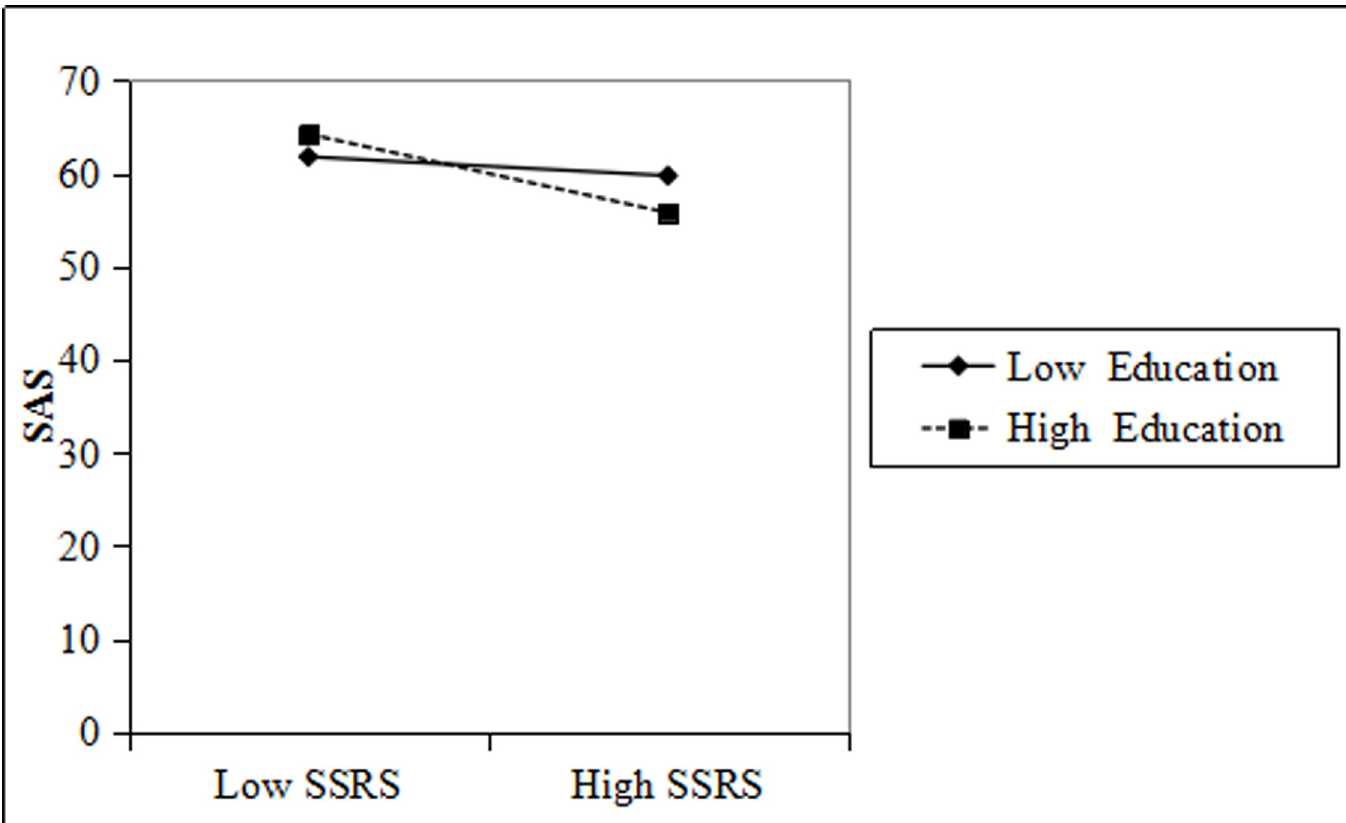
Fig 4. Education moderation interaction diagram for SSRS and physician